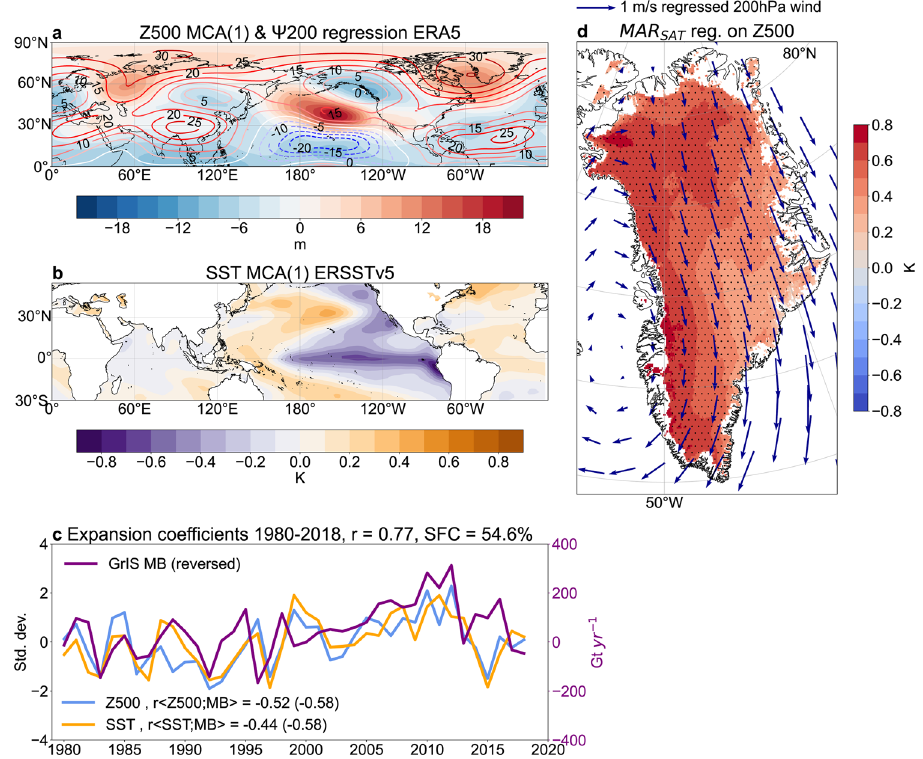
Fig. 4 | The contribution of remote forcing to high-pressure driven adiabatic processesovertheGrISduring1980 – 2018. Spatialpatternscorrespondingtothe leadinginternalmodeofco-variabilitybetweenNorthernHemisphereannualmean a ERA5 500hPa geopotential height (Z500) and b sea surface temperatures (ERSSTv5,SST)(30°S – 55°N).Thecorrespondingexpansioncoef fi cients(EC,shown as units of standard deviations) for Z500 (blue) and SST (ERSSTv5, orange) as revealed by maximum covariance analysis (MCA, Methods) also shown in c . The shared fractionofcovariance(SFC)is54.6% and the correlation betweenthe ECsis r=0.77.Thearea-weightedglobalmeanisremovedbeforeMCAfromZ500andthe